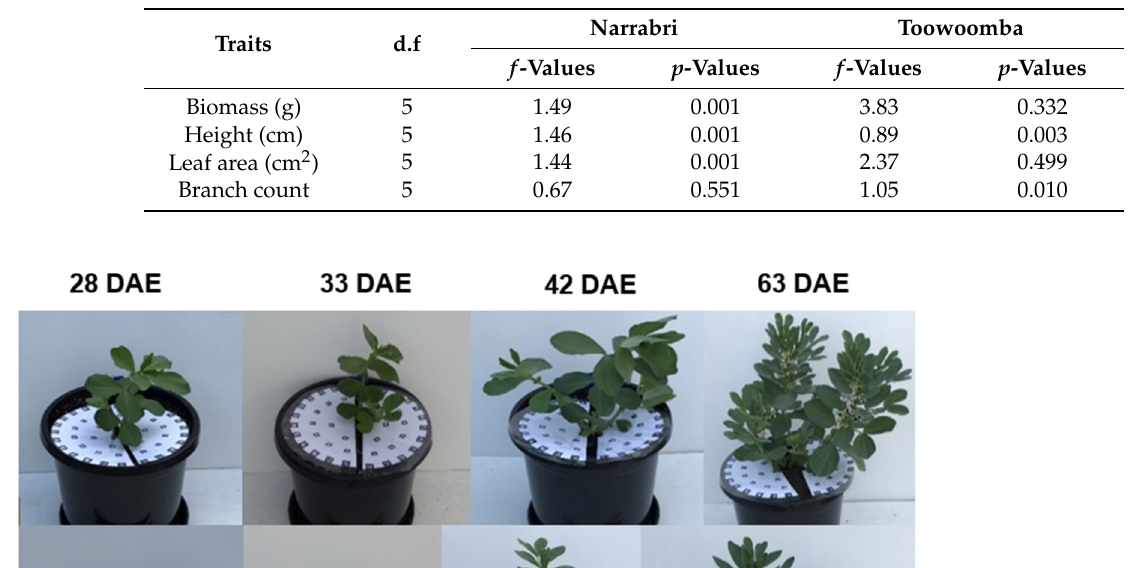
Table 5. Plant height (cm) of different faba bean cultivars grown in Narrabri and Toowoomba. Means with a different letter are significantly different at p -value ( α =